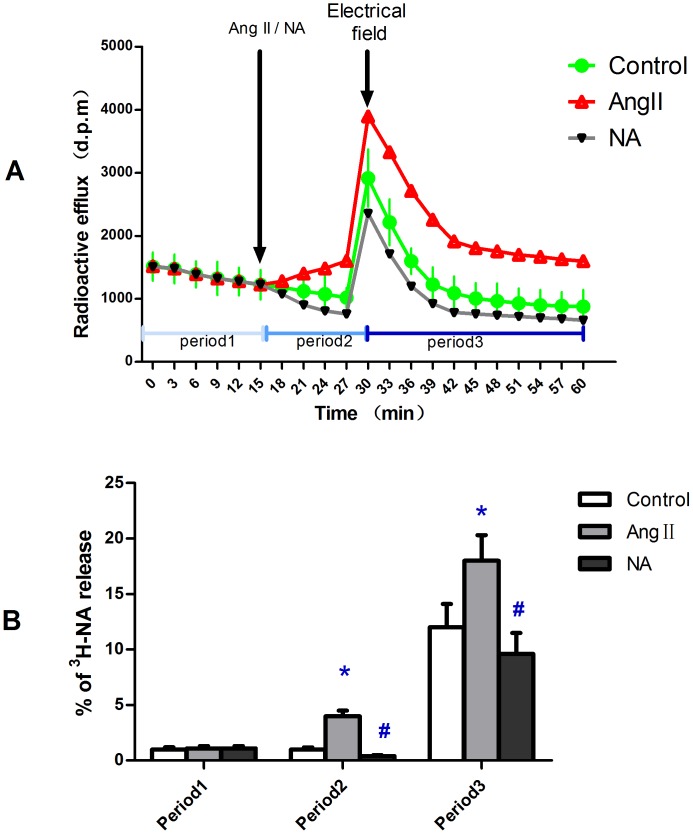
In vitro experiments on SD rat aorta rings investigating NA release using isotope labelling.Ang II or NA was added 15 min before electrical field stimulation. In each period of time the release fraction was calculated according to the expression given formerly. A: release curve graph of 3H-NA. B: statistical chart of % 3H-NA release in three periods of time. Period1: spontaneous release; period2: spontaneous release after Ang II or NA were added in; period3: electrical field stimulated release after Ang II or NA were added in. Data shown are means ±SD. *P<0.01 related to control, #P<0.05 related to control.